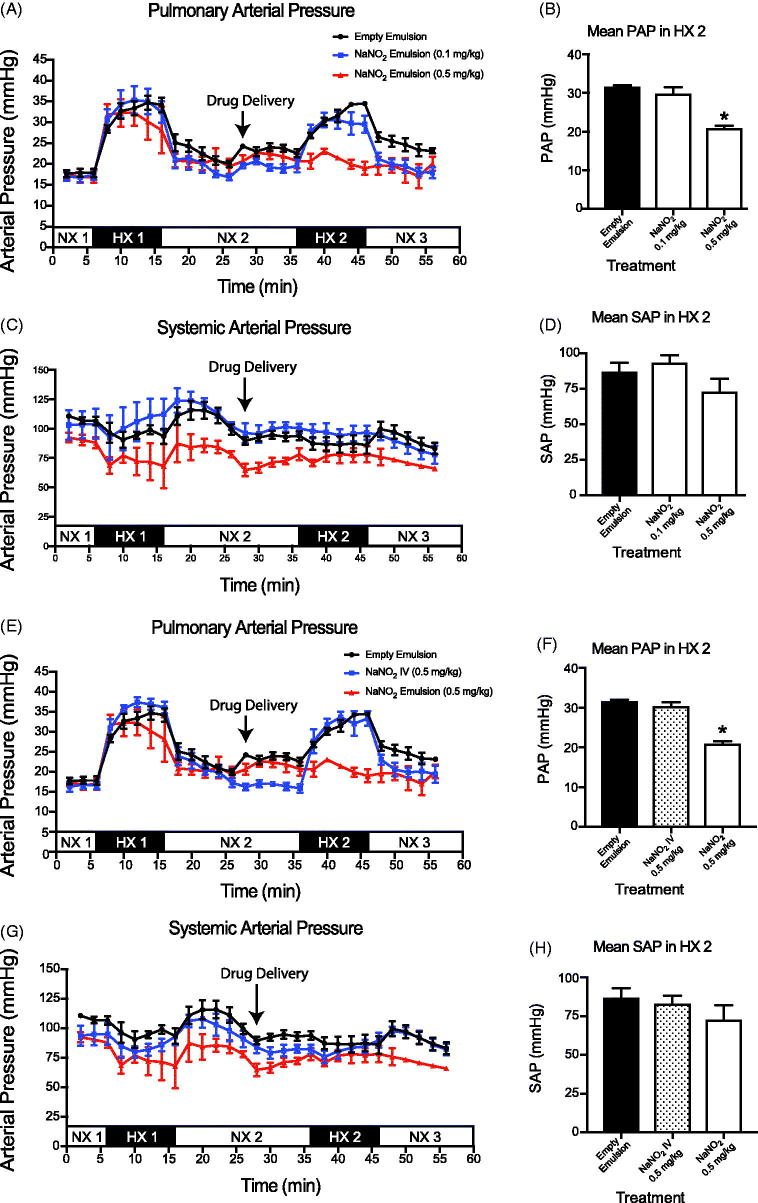
In vivo evaluation of the delivery of sodium nitrite (NaNO2) (Doty et al.,2017). Mean pulmonary artery pressure (PAP) of intrapulmonary treatment groups. (C, D) Mean arterial pressure (MAP) of intrapulmonary treatment groups. Measurements were recorded at 2 min intervals and represent mean ± SEM. Bar graphs represent the average pressure ± SEM over the 10 min time span of the second bout of hypoxia (HX 2). Empty Emulsion (•); NaNO2 Emulsion (0.1 mg/kg) (); NaNO2 Emulsion (0.5 mg/kg) (); NX - normoxic; HX - hypoxic. *p < .05 (Haase et al.,2010). Mean pulmonary artery pressure (PAP) of intravenous infusion and NaNO2 emulsion (Isaac et al.,2006). Mean arterial pressure (MAP) of intravenous infusion and NaNO2 emulsion. Empty Emulsion (•); NaNO2 IV () NaNO2 Emulsion (0.5 mg/kg) ().